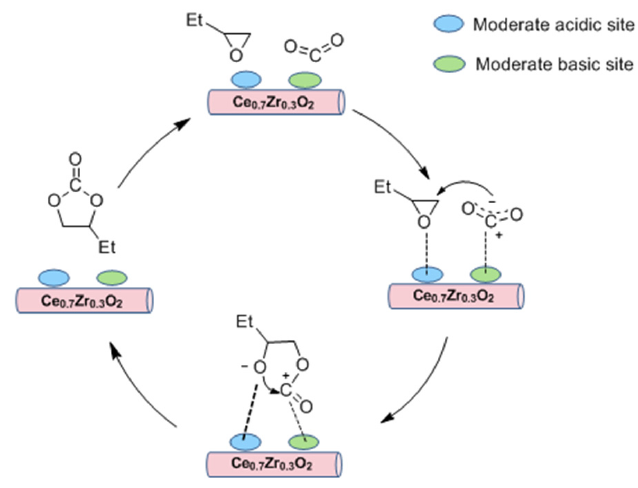
Figure 7. Mechanism of cycloaddition of CO 2 with butylene oxide.